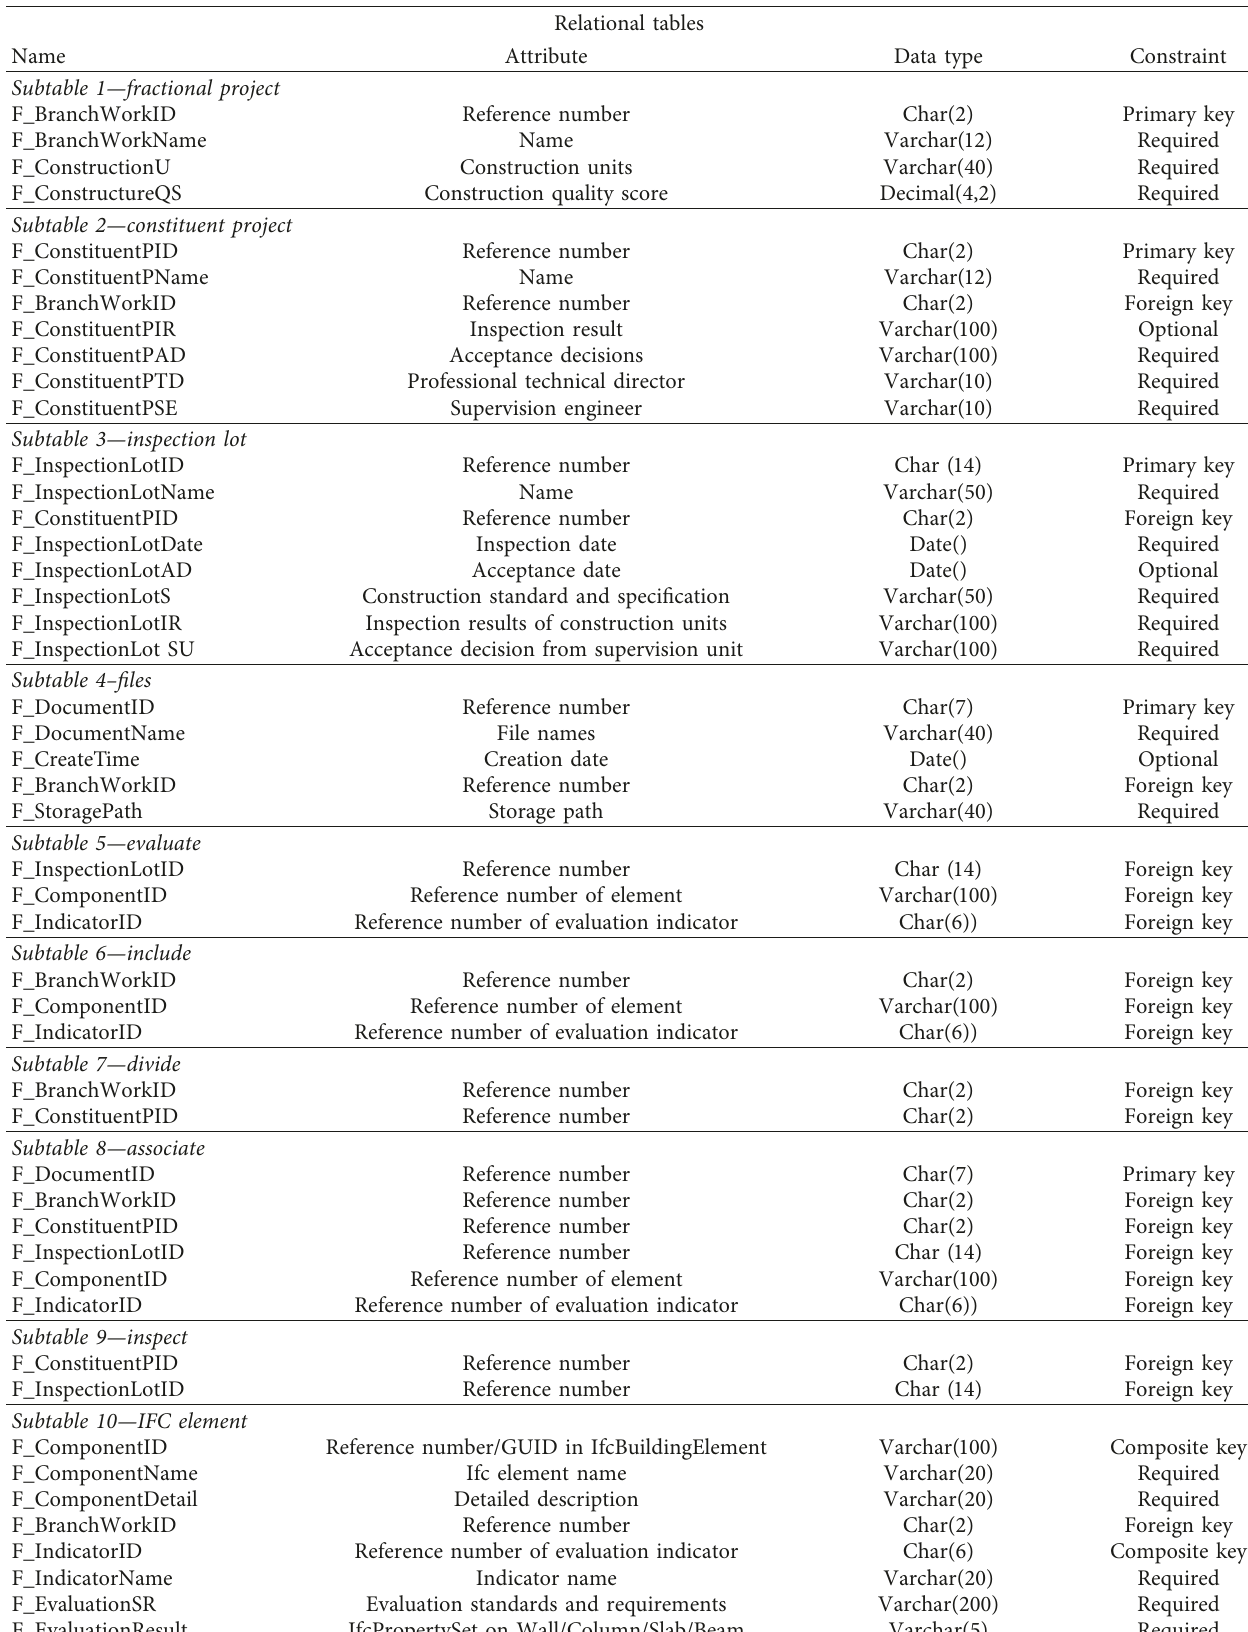
Table 13: Relational tables of the